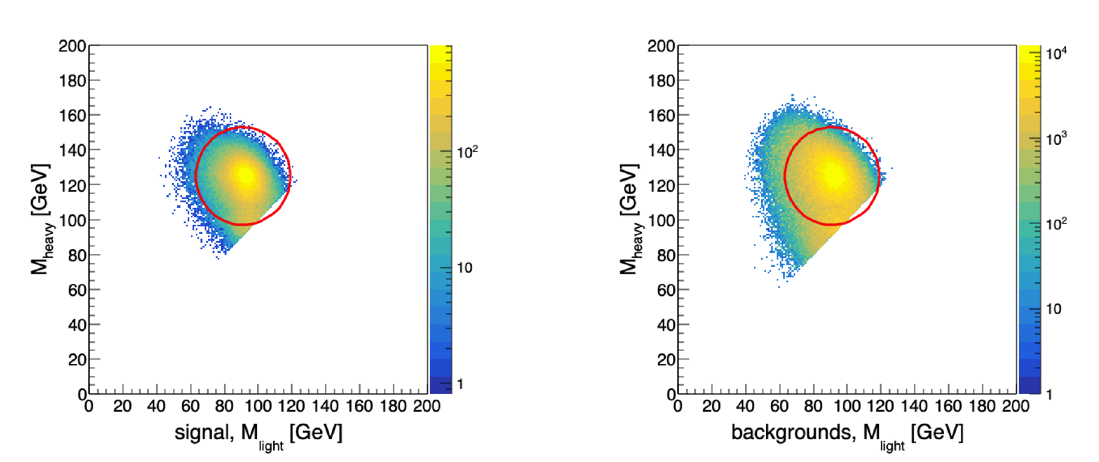
Figure 9 . The mass distribution of two di-jet systems, the left plot refers to the signal, the right to the